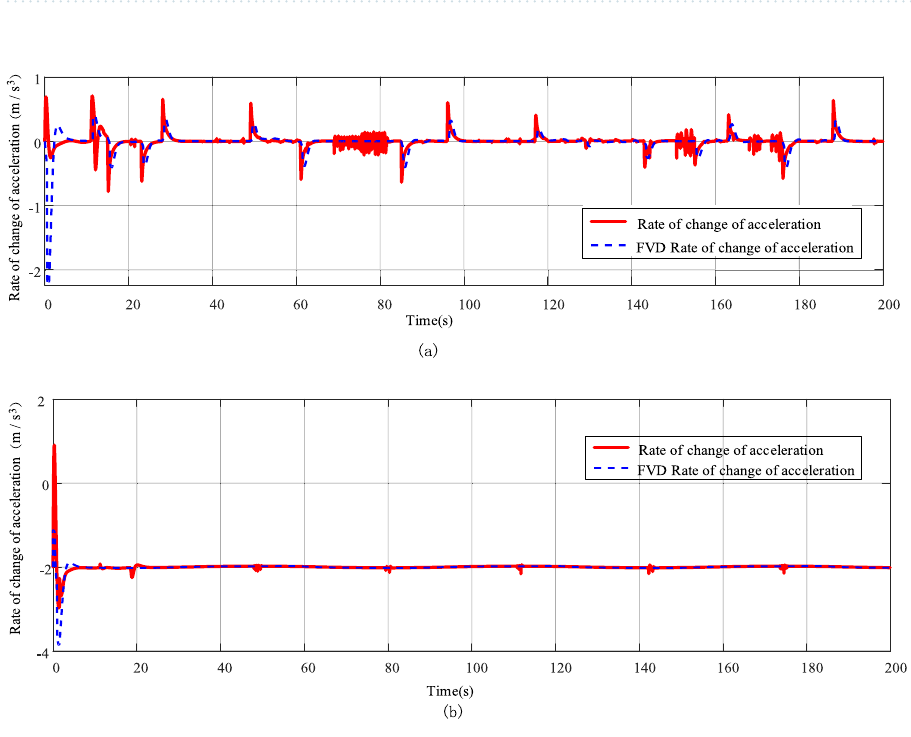
Figure 14. ( a ) Simulation results of the rate of change of following acceleration corresponding to working condition 1. ( b ) Simulation results of the rate of change of following acceleration corresponding to working condition